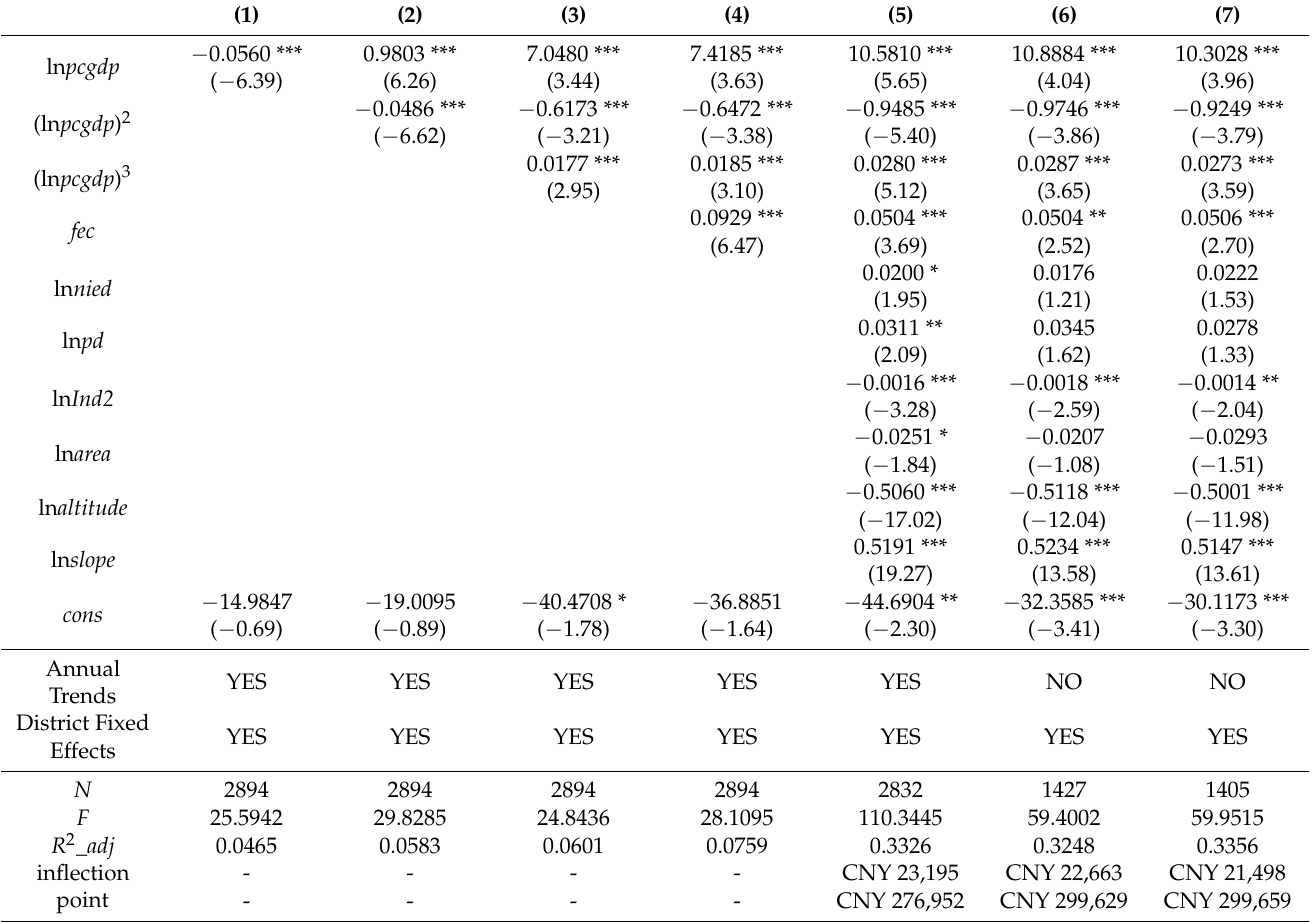
Table 2. Basic regression empirical results of the relationship between economic development and ecological